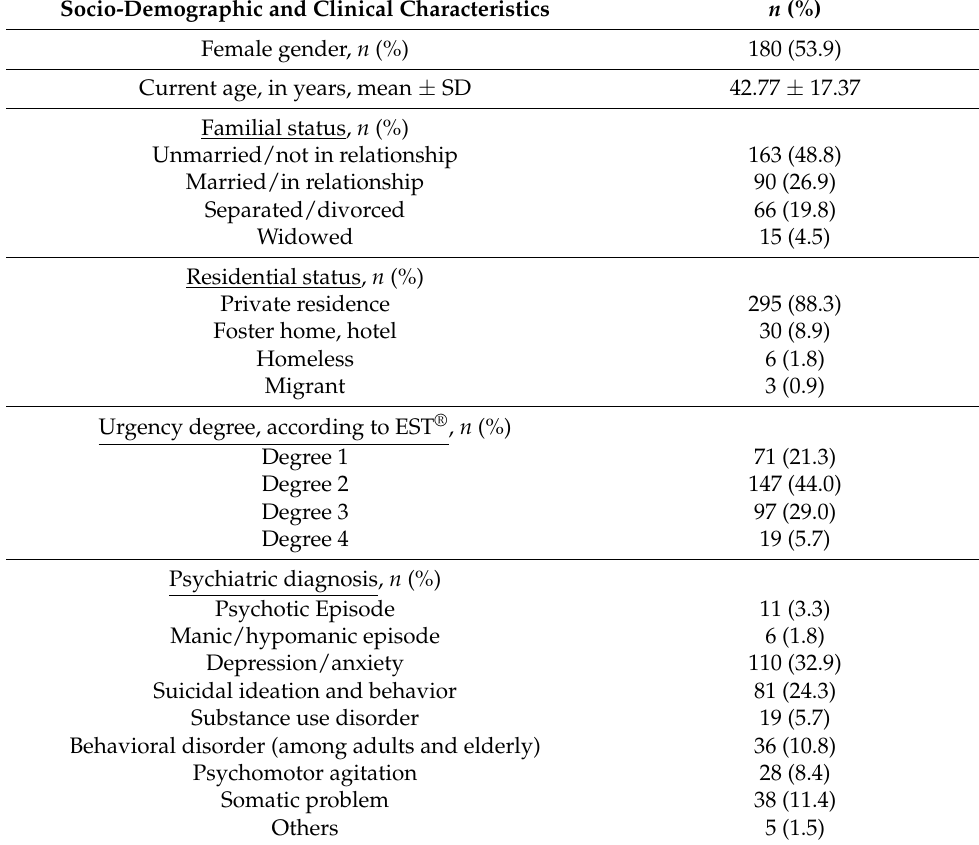
Table 1. Socio-demographic and clinical characteristics of patients who expressed one or more COVID-19 related fears ( n = 334).